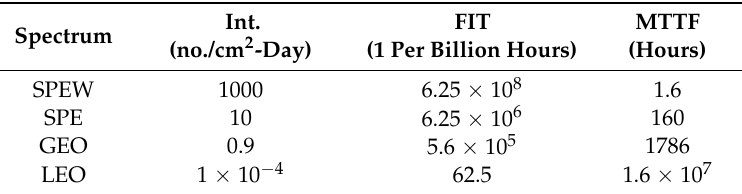
solar min. from CREME96.